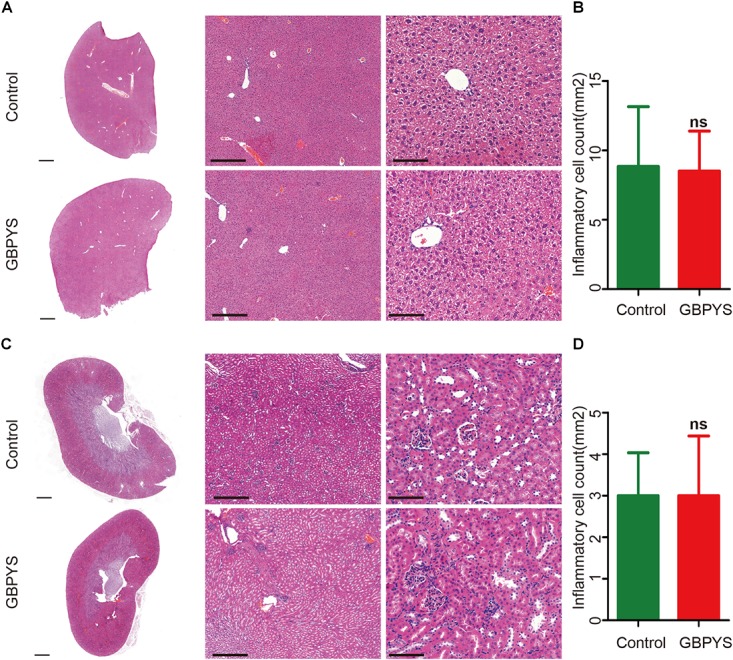
GBPYS feeding for 3 months had no apparent toxicity to liver and kidney in normal mice. (A) GBPYS feeding for 3 months had no significant toxicity to liver in normal mice compared with Ctrl normal mice fed with regular food (n = 6). (B) Quantification of inflammatory cells around the hepatic junction from six liver slides. (C) GBPYS feeding for 3 months had no significant toxicity to kidney in normal mice compared with Ctrl normal mice fed with regular food (n = 6). (D) Quantification of inflammatory cells around the blood vessels from six kidney slides. Scale bars, 2 mm, 200 μm, 50 μm, respectively. ns, P > 0.005.